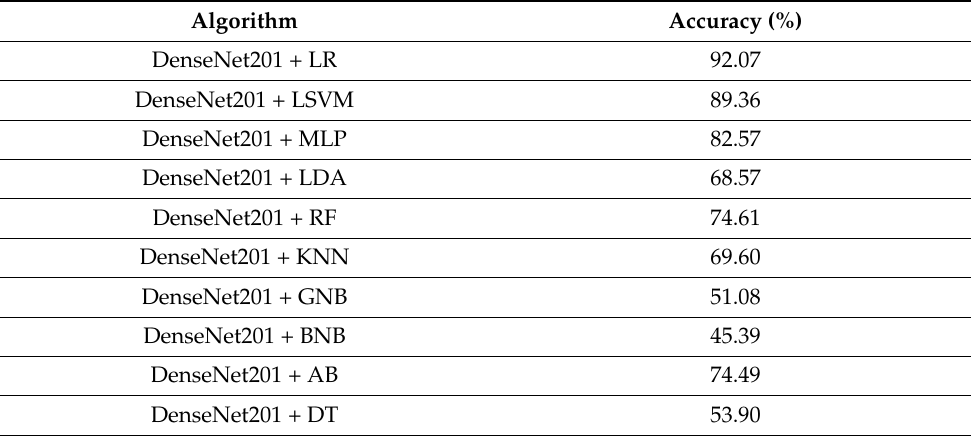
Table 8. Test accuracy results with data augmentation.